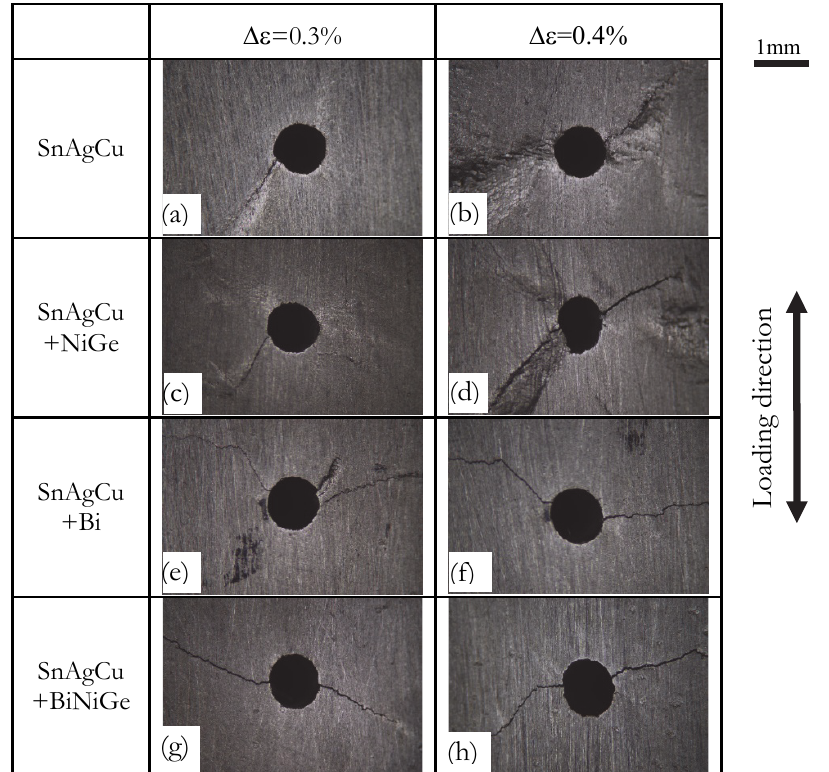
Figure 4: Crack propagation observations after the